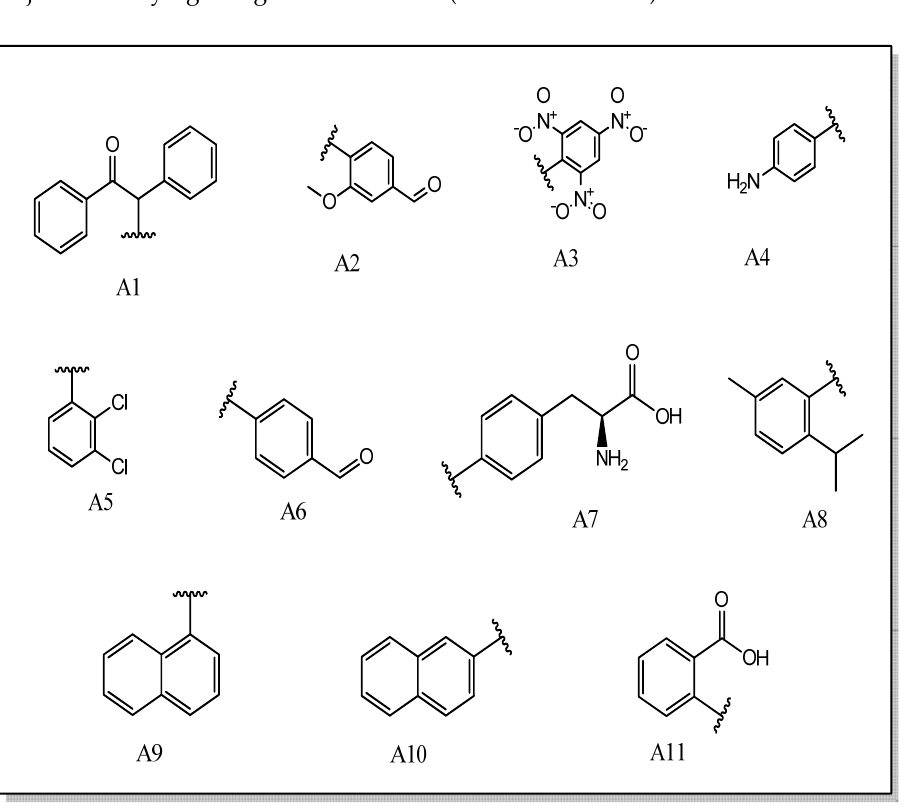
Figure 3 . Different alcohols ‐ phenols (A1–A11) used in the synthesis of valsartan derivatives AV1 ‐ Figure 3. Different alcohols-phenols (A1–A11) used in the synthesis of valsartan derivatives AV11.